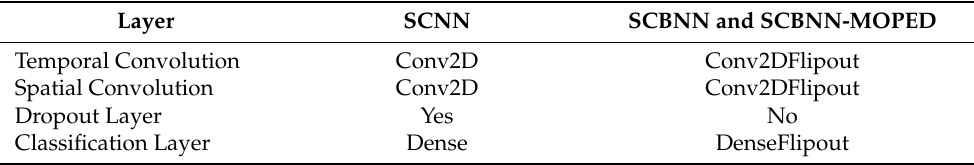
Table 1. Comparison between SCNN and the two proposed Bayesian neural